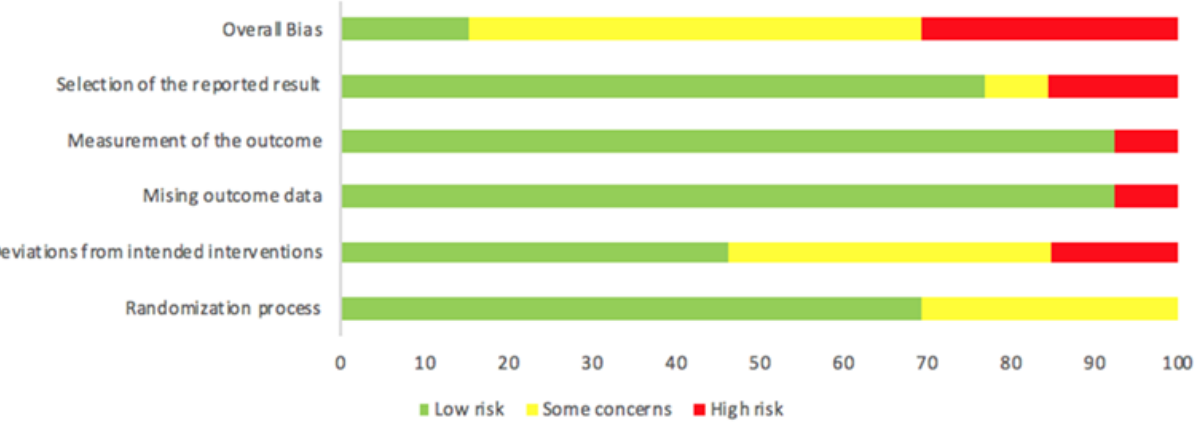
Figure 2. Risk of bias of included randomized controlled trials.